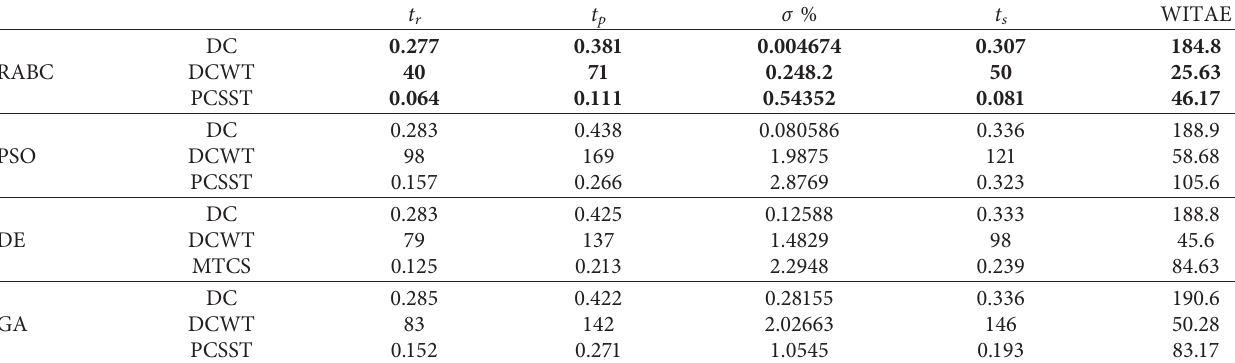
� 10, and a � 20. 1 3